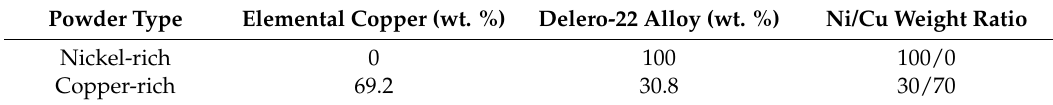
Table 2. Compositions of blended powder feedstocks used in the study.